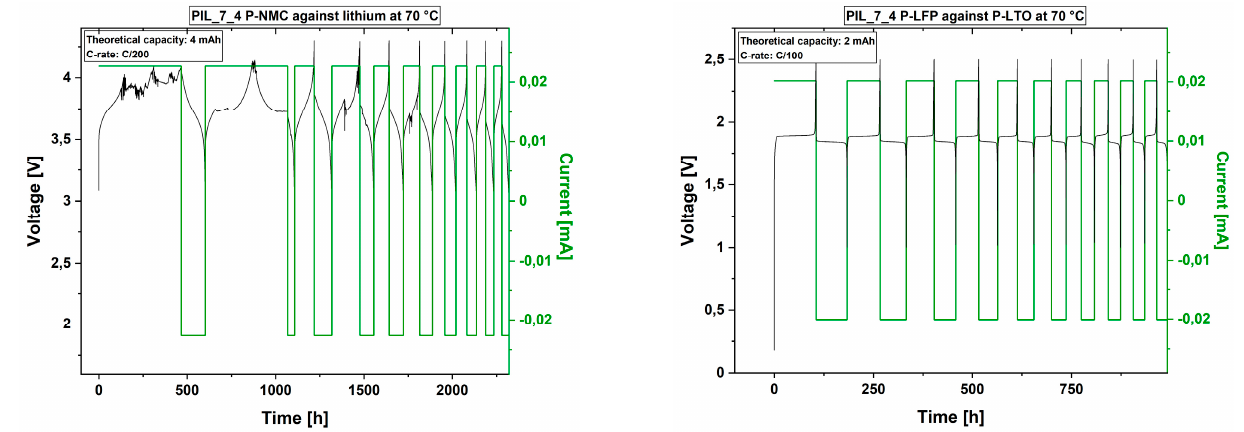
Figure 7. First 10 cycles of the cell test of the polymer electrolyte with MPPyrr-TFSI to EC ratio of 1:1 (PIL_7_4) at 70 °C with the electrode combinations NMC111 against lithium ( left ; C/200) and lithium iron phosphate against lithium titanate ( right ; C/100). Images including all executed cycles are given in the Supporting Material section (Figure S5).